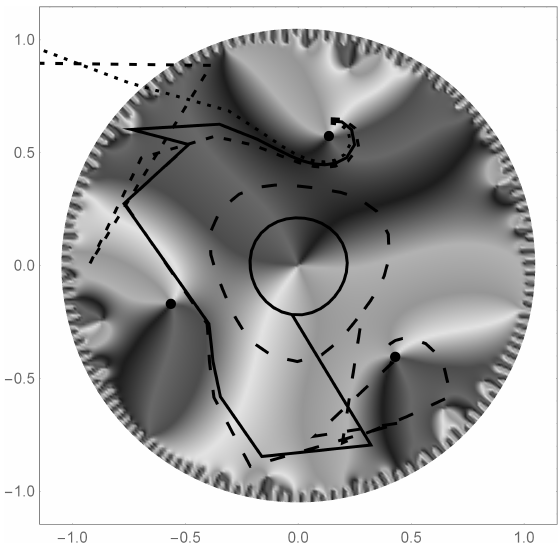
Figure 14. Iterative trajectories for several nearby initial points for the case of k = 3 and θ = 11.225 ◦ . The solid line is for the initial point z 0 = 0.15 + 0.64 i , N = 10 and 500 iterative steps (the stable orbit is reached after approximately 50 steps). The small and medium sized dashed lines show the trajectories for z 0 = 0.15 + 0.63 i and z 0 = 0.15 + 0.65 i respectively. Both of these trajectories exit the unit disk and diverge after 14 and 16 steps respectively. The large dashed line is again for z 0 = 0.15 + 0.64 i but now N = 9 (still 500 iterative steps). A different stable orbit is reached after approximately 70 steps and after an excursion to the area near the lower right primary fixed